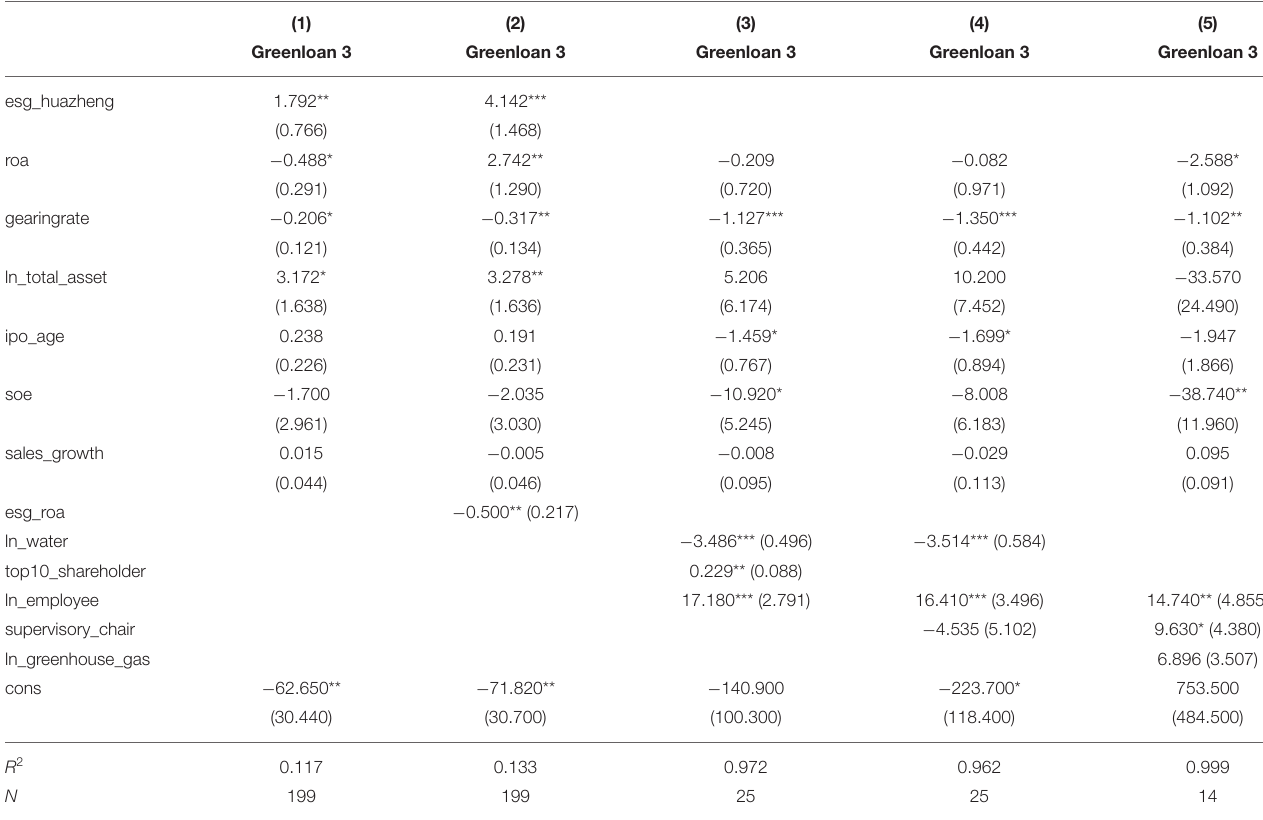
TABLE 5 | The volume of green bond issuance within listed